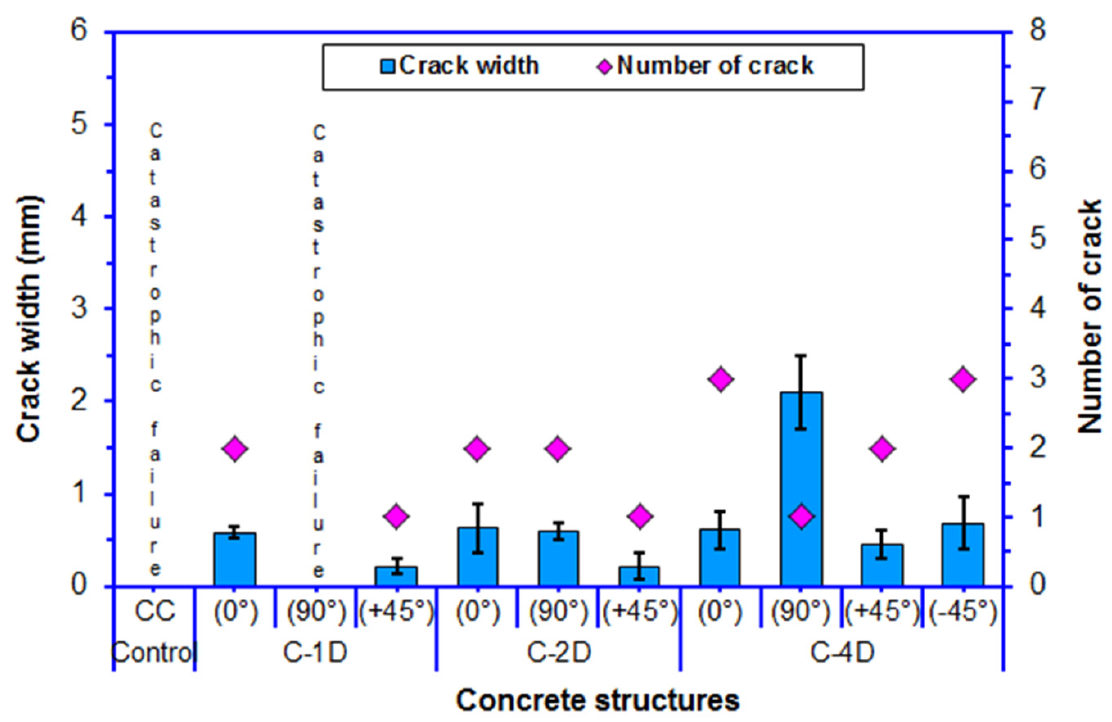
Figure 19. The number of Cracks and their width in the failed samples after the off-axis four-point flexural test. Various fractured multiaxis 3D carbon fiber concretes including C-1D-(0°, 90° and +45°), C-2D-(0°, 90°, and +45°), and C-4D-(0°, 90°, +45°, and − 45°), as well as the neat con- cretes on the top, bottom, and cross-sections and their failure modes after the off-axis